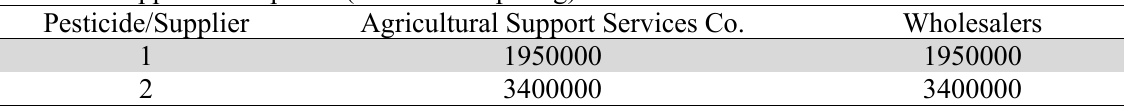
Pesticides' suppliers and prices (Iranian Rial per kg) Pesticide/Supplier Agricultural Support Services Co.